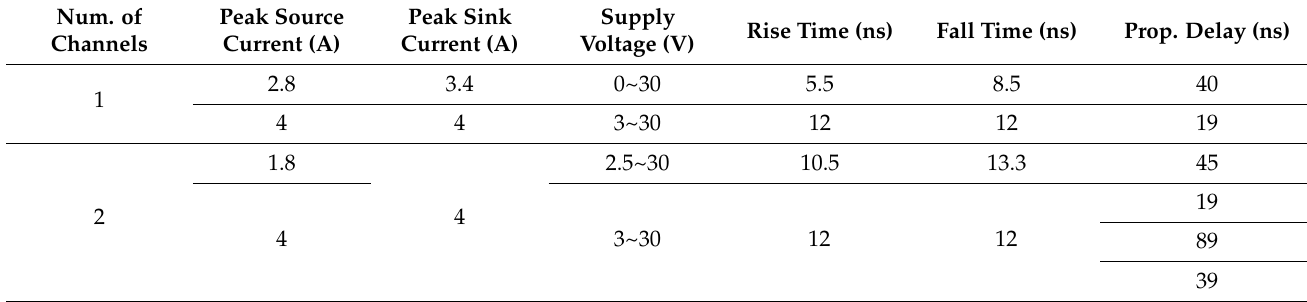
Table 33. Commercial SiC MOSFET drivers by Silicon